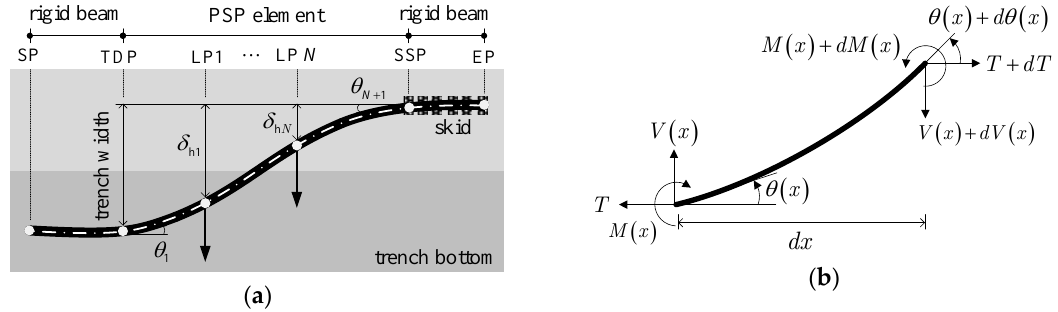
Figure 5. Segmental pipeline model in the lateral (x-z) plane: (a) pipeline model using a pipeline suspended by pipelayers (PSP) model element; (b) deflected element of a Euler-Bernoulli beam.